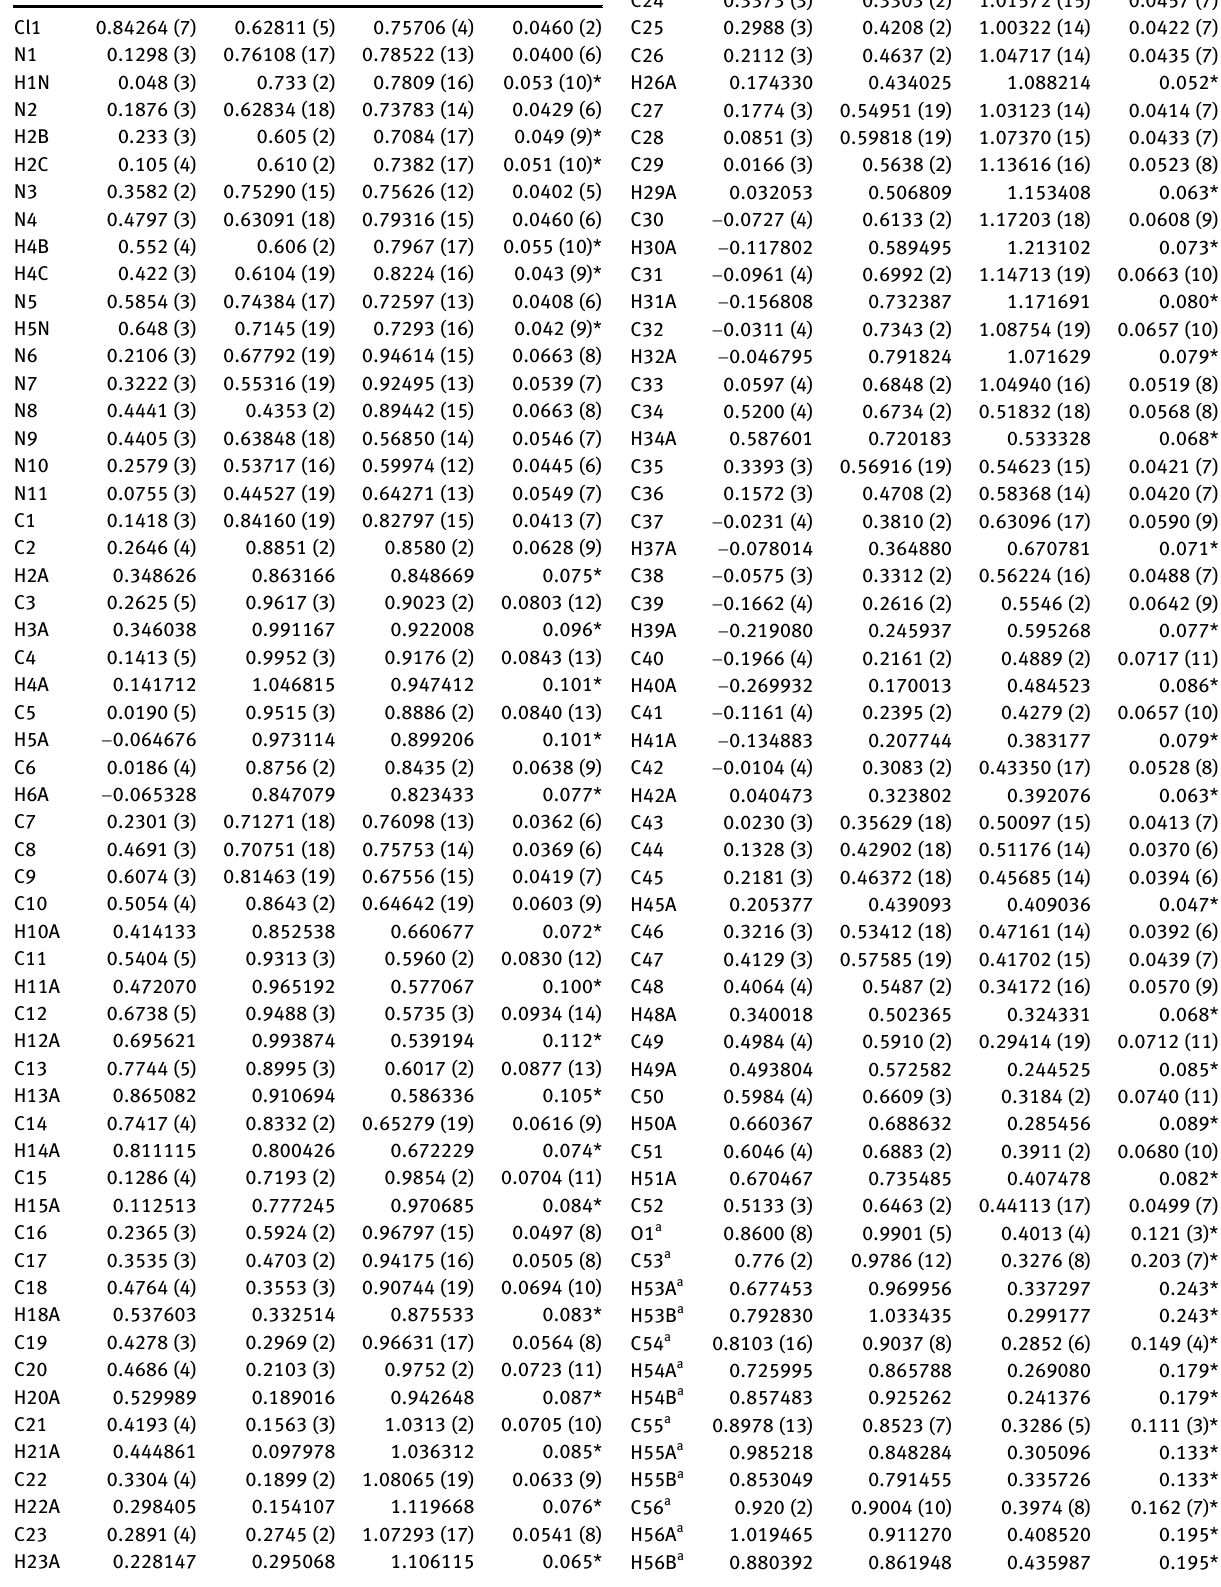
Table  : Fractional atomic coordinates and isotropic or equivalent isotropic displacement parameters (Å 